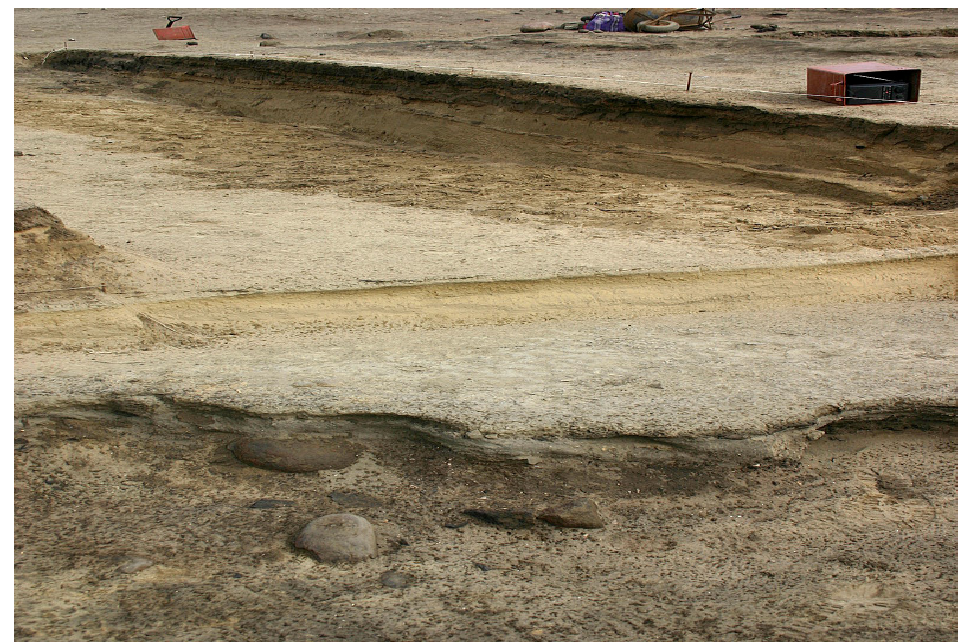
Figure 18. A further early coastal ancient linear beach ridge, now partially covered by aeolian sand drifts; further stranded beach ridges are to be found closer to the shoreline resulting from later El Niño flood events. Ongoing tectonic uplift helps to strand and separate a sequence of beach ridges.